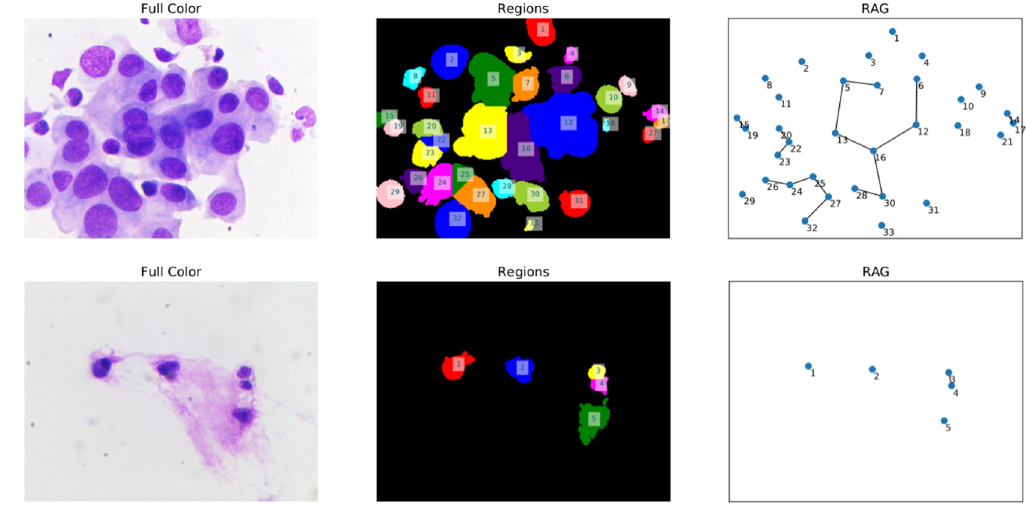
Figure 6. Main steps of agglomeration computation. Input image (full color) and output image (regions) of the cell detection algorithm. Input image (regions) and output object (RAG) of the RAG build process. Notice the one-to-one relation between vertices and regions, as each vertex has the same region identifier (upper half: SM; lower half: CYT).